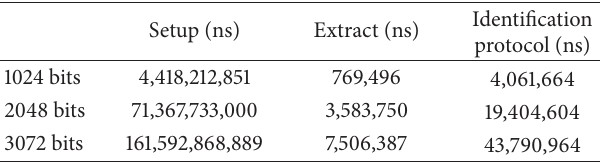
Identification protocol (ns)